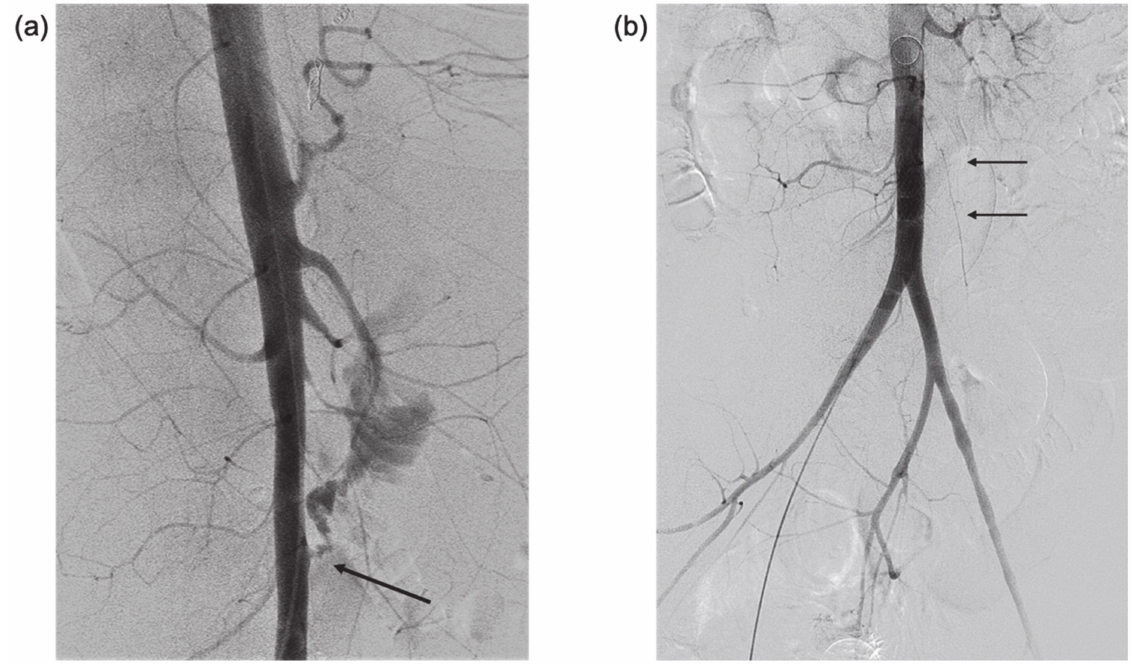
Figure 2. ( a ) Lateral digital subtraction aortography showing active contrast extravasation from the anterior infra renal aorta into small bowel lumen (arrow)—AEF. Note the diffuse small caliber branch vessels due to vasoconstriction in the setting of hemorrhagic shock. ( b ) Anterolateral aortogram after covered stent deployment in the infra renal aorta, covering the AEF (arrows). Note that extravasation is no longer seen, and there is some increase in vessel caliber due to improved hemodynamic